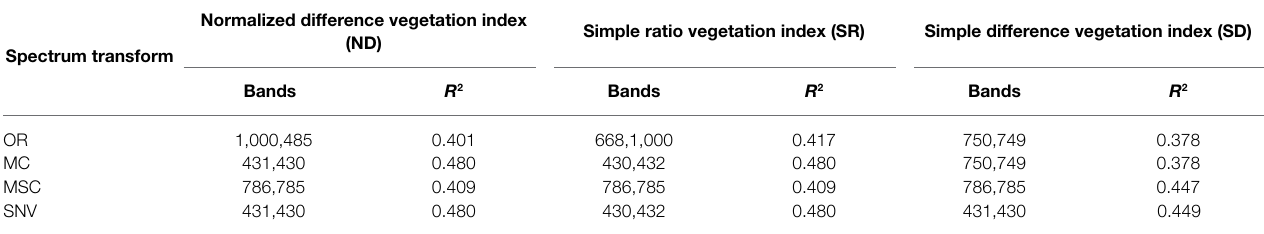
TABLE 1 | Optimized forms of optimal two-band combinations and monitoring performance.